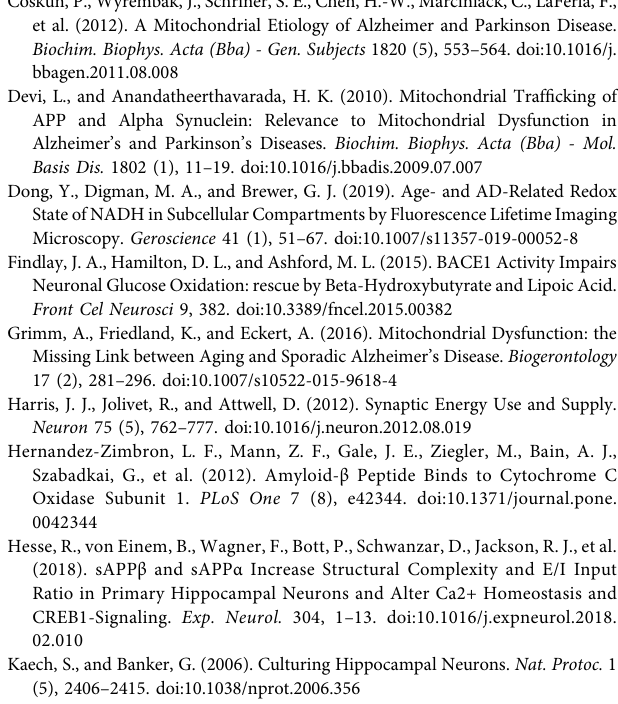
SUPPLEMENTARY FIGURE 3 | Expression of control vector does not affect the NADH lifetime. (A,B) Correlation of the mitochondrial matrix pH with the normalized overexpressionstrengthofAPP(black),BACE1(lightgray),andAPPswe(darkgray), quanti fi ed as mCherry fl uorescence intensity, on the single-soma level. The same neurons were imaged before (A) and after (B) antimycin A treatment (n (cid:2) 5, > 120 somata). (C) Correlation of the mean NADH lifetime with expression strength of pUltra-hot control in untreated (black) and acute antimycin A – treated (gray) neurons on the single-soma level (n (cid:2) 2, > 20 somata). The lines in the scatterplots represent local regression (loess) curves to visualize the nonlinear regressions. Signi fi cance indicated as p -value [ p ] versus the 21 (A,B) or 9 (C) least transduced neurons was evaluated using a sliding window and a permutation test and plotted below the